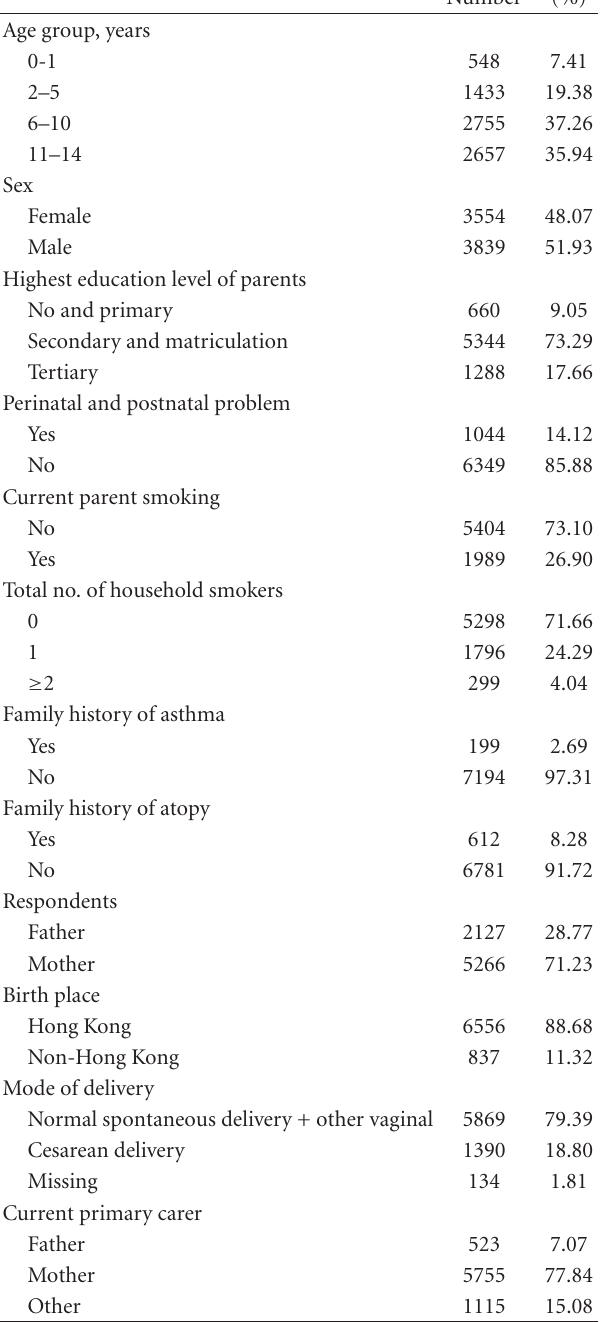
Table 1: Baseline characteristics of survey participants ( N =